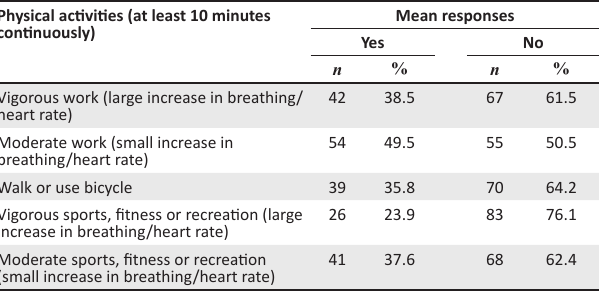
TABLE 5: Physical activities amongst participants. Physical activities (at least 10 minutes